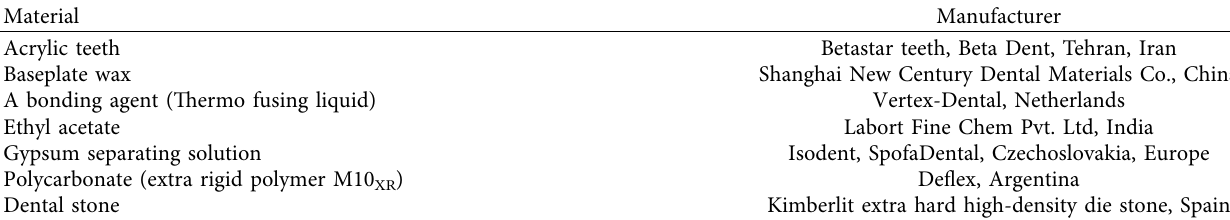
Table 1: Materials used to prepare the test samples.